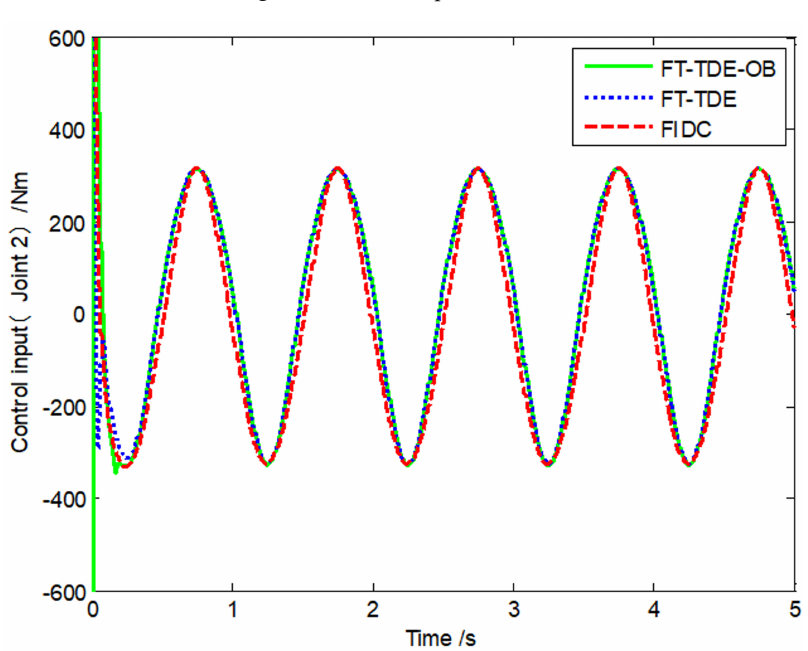
Figure 8. Control input of Joint